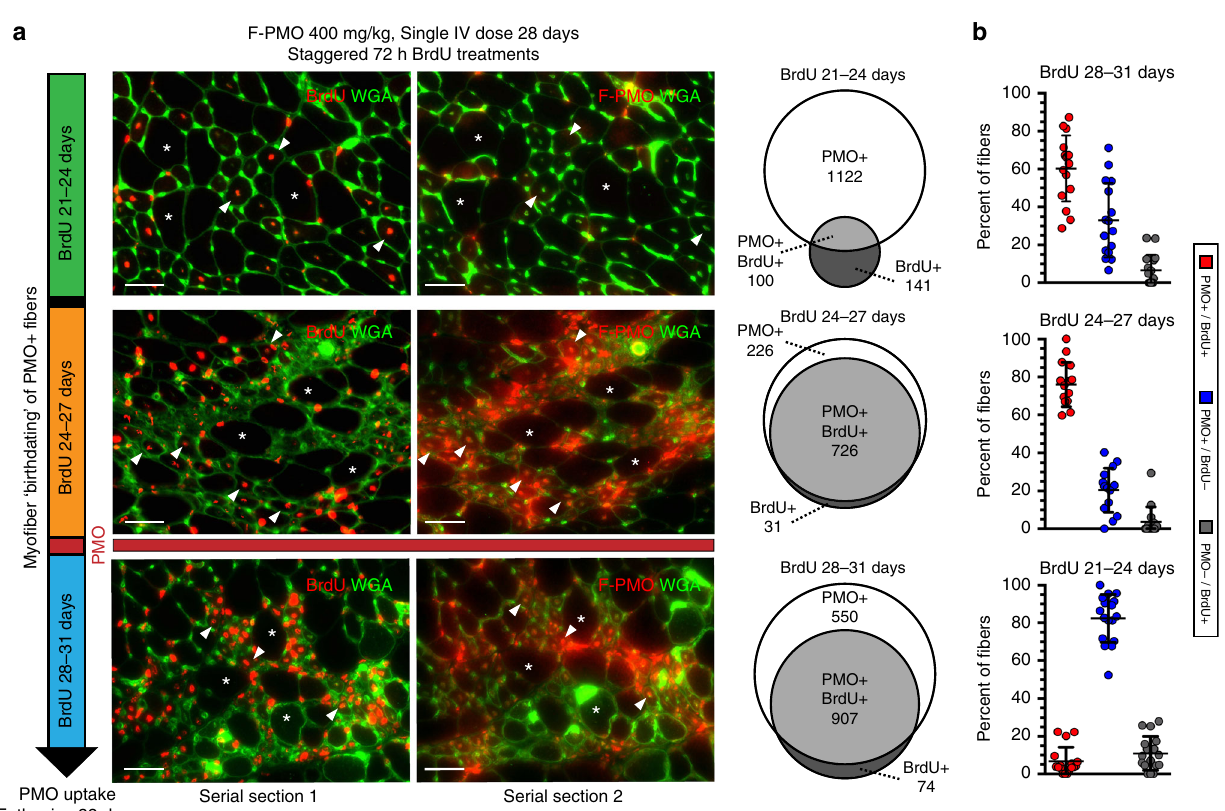
Fig. 6 Robust PMO uptake in actively regenerating myo fi bers concurrent with systemic PMO delivery. a Myonuclear PMO uptake after single IV dose of F-PMO (400 mg/kg, n = 3) in 4 week mdx mice treated with staggered pulses of BrdU (refer to Fig. 1c “ PMO uptake ” ). Note, asterisks denote fi ber identity between serial cross-sections and arrowheads denote examples of centrally-nucleated BrdU +ve /PMO +ve myo fi bers. Venn diagrams demonstrate the overlap between F-PMO localization (PMO +ve ) and myo fi ber regeneration (BrdU +ve ). Scale bars represent 50 μ m. b Quanti fi cation of PMO +ve /BrdU +ve , PMO +ve /BrdU − ve , and PMO − ve /BrdU +ve myo fi bers shown as percent of labeled fi bers per BrdU cohort ( n = 3 mice per cohort). Statistical